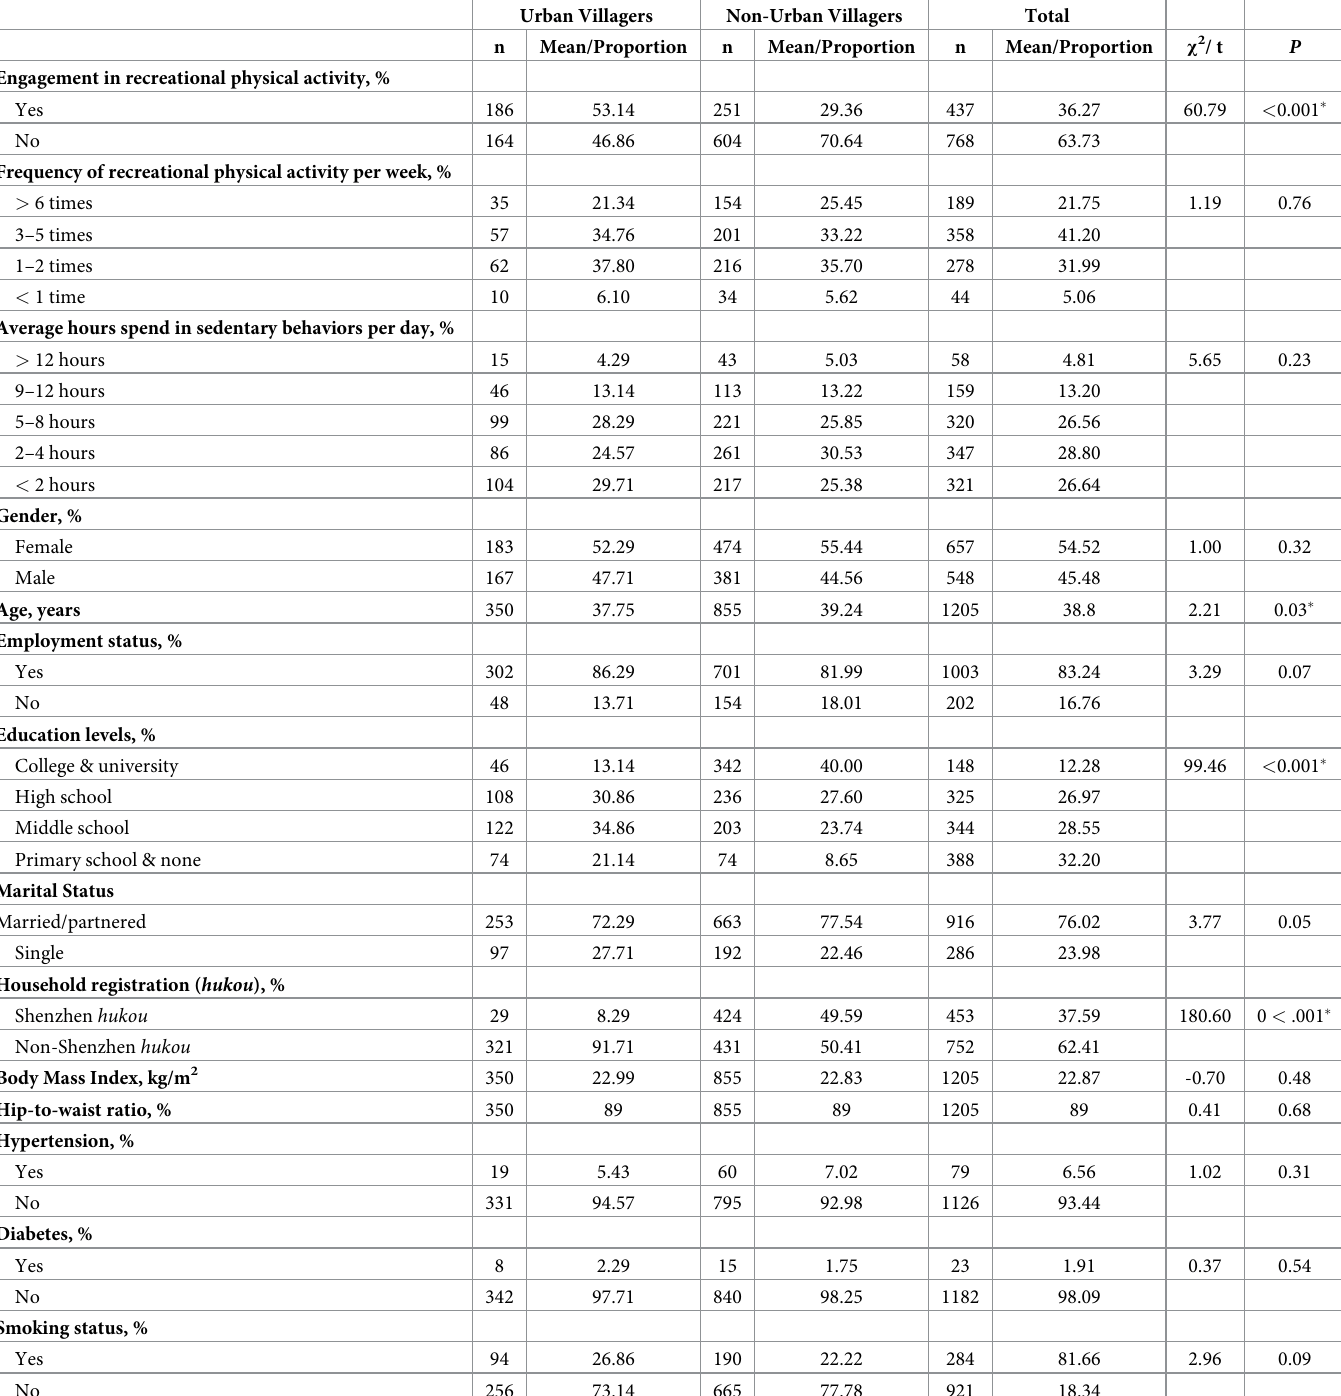
Table 1. Characteristics of urban villagers and non-urban villagers engaging in recreation physical activity.